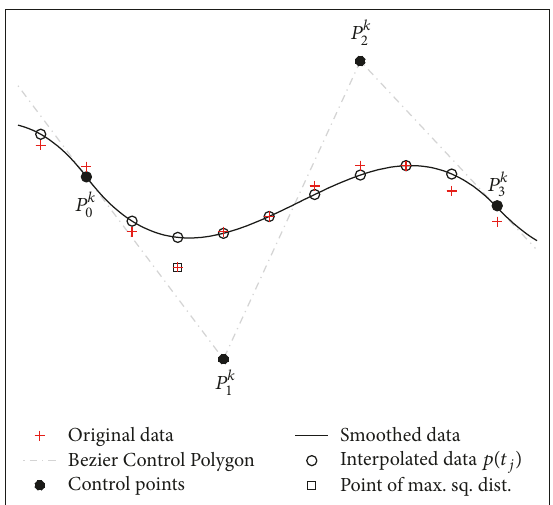
Figure 4: Smoothing strategy illustration for the k th